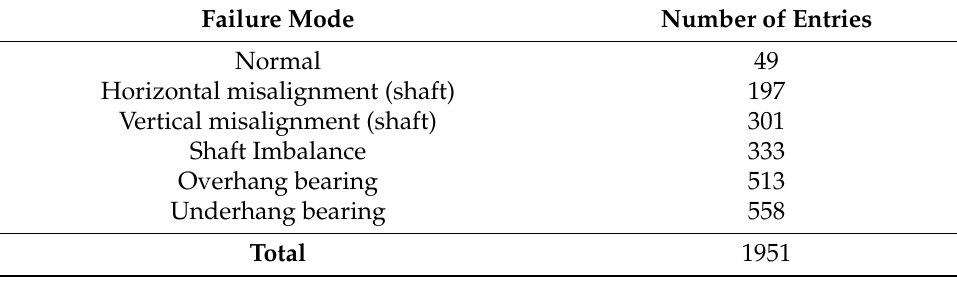
Table 1. The table provides details on the dataset, as it was used in the study.